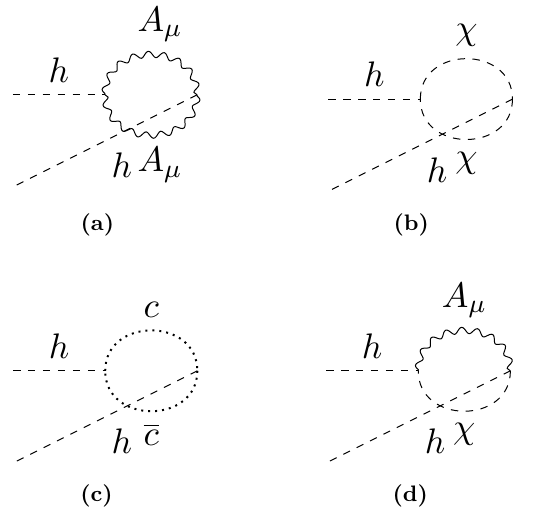
Figure 8. The O ( p 2 ) terms in these diagrams form the leading order contributions to Z ( φ